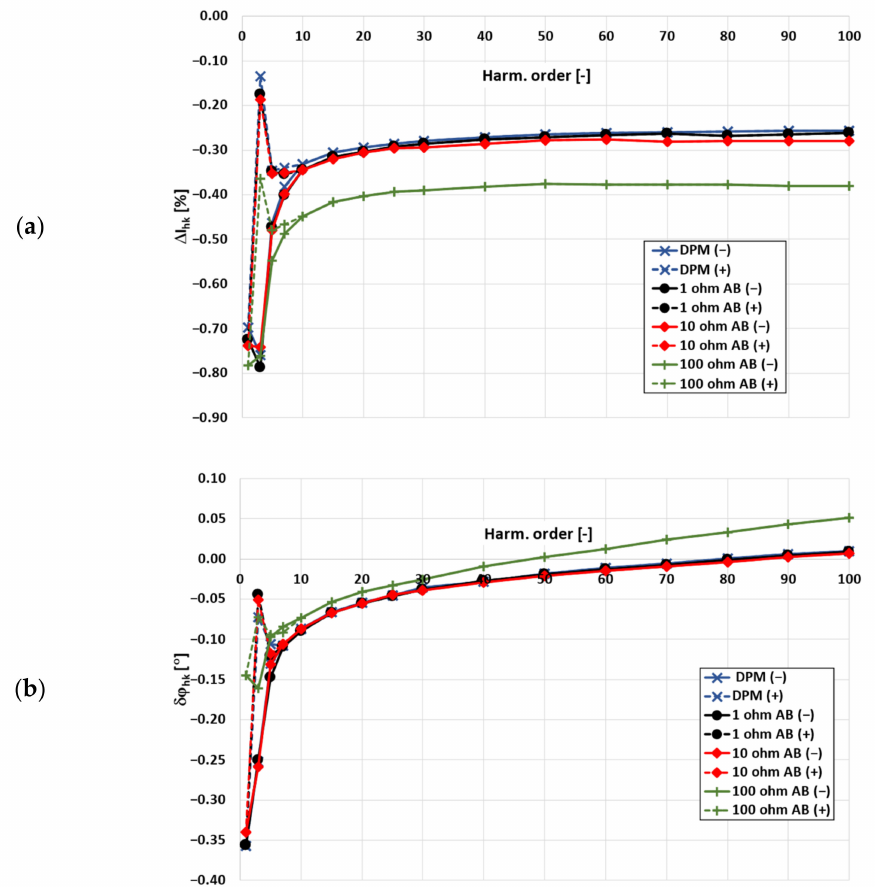
Figure 5. The influence of the self-generated low-order higher harmonics from the wideband-type CT and the current shunt resistance on current error ( a ), phase displacement ( b ), for 20% of the rated primary current and rated resistance load (used notations are as in Figure